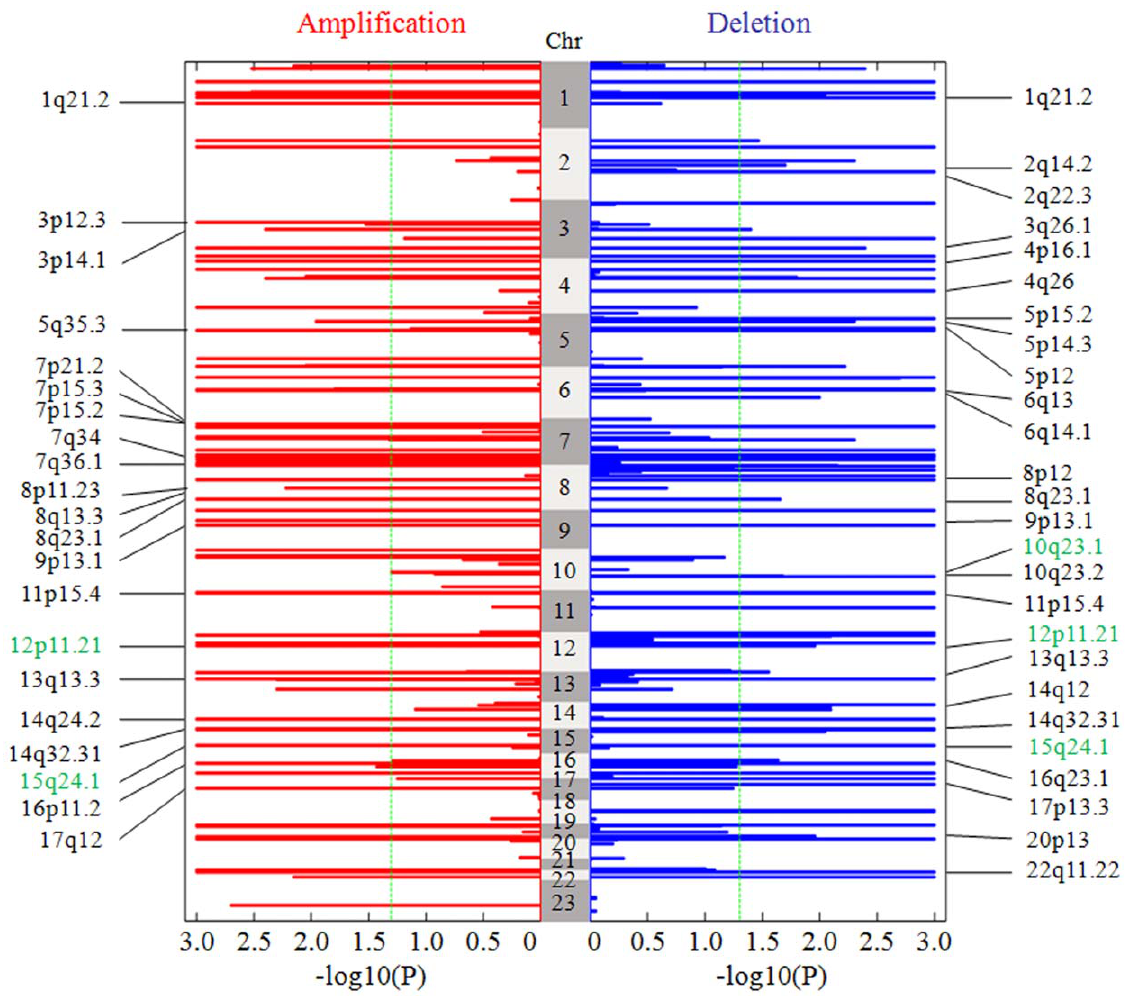
Figure 6. The landscape of statistical significance levels of the genome in the 82 prostate adenocarcinoma subjects. 2 log10 (p- values) are given for amplification and deletion regions respectively. The dashed green line is placed at 1.3 (corresponding p-value of 0.05) as a cutoff for calling significant consensus events. Chromosome 23 indicates the sex chromosome. Many important SCEs are listed in the both sides of the figure.